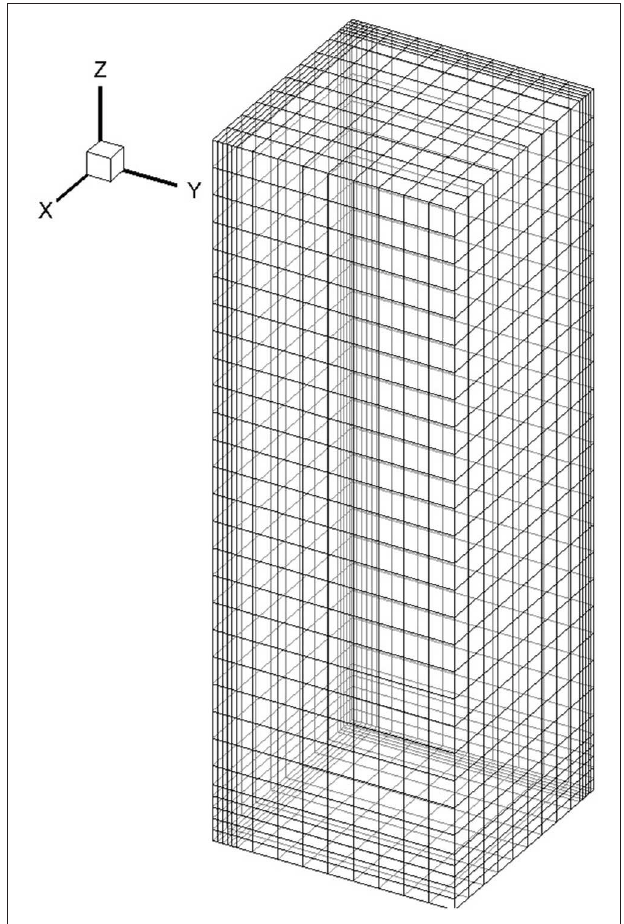
FIGURE 2 | Cartesian mesh used for the computation of air-fountain experimental